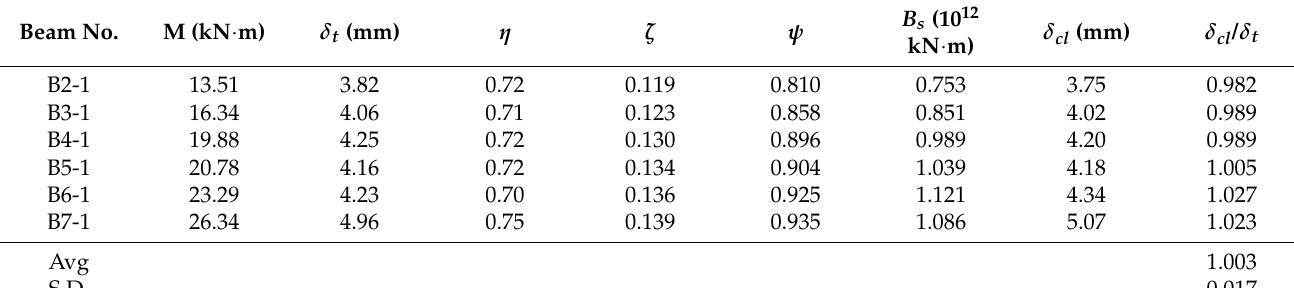
Table 6. Regression calculation results of mid-span deflection.